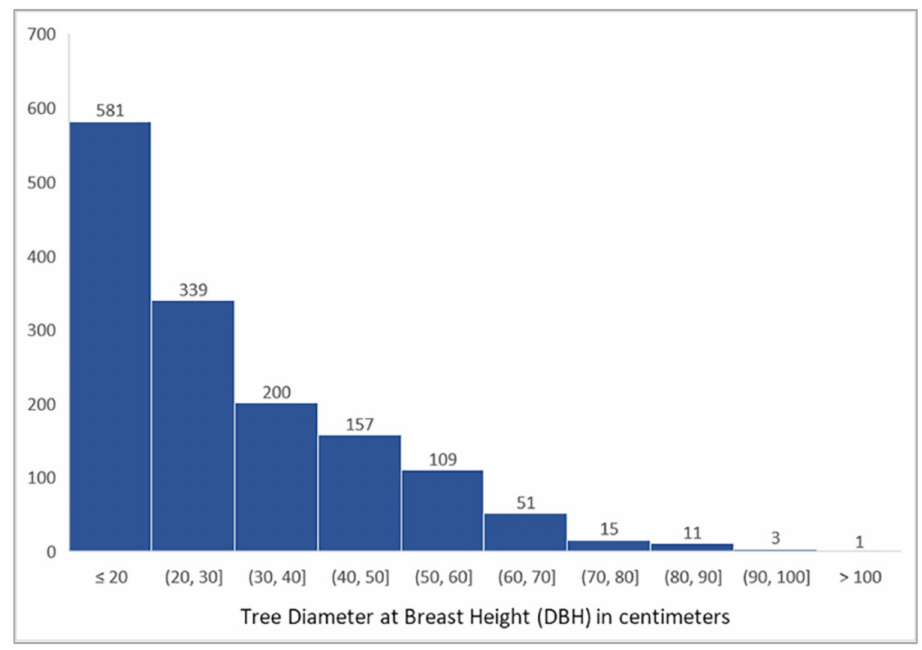
Figure 4. Distribution of study area trees by diameter at breast height (DBH).